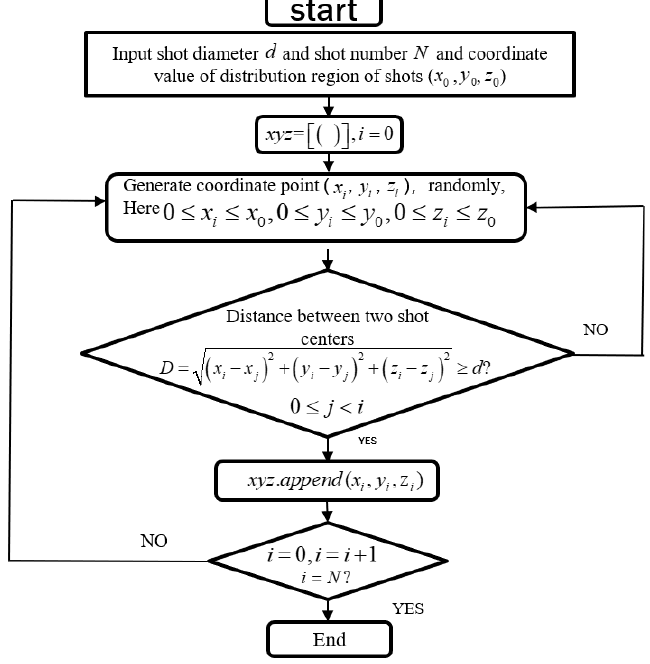
Figure 7. Python program frame for random coordinates of N shots.